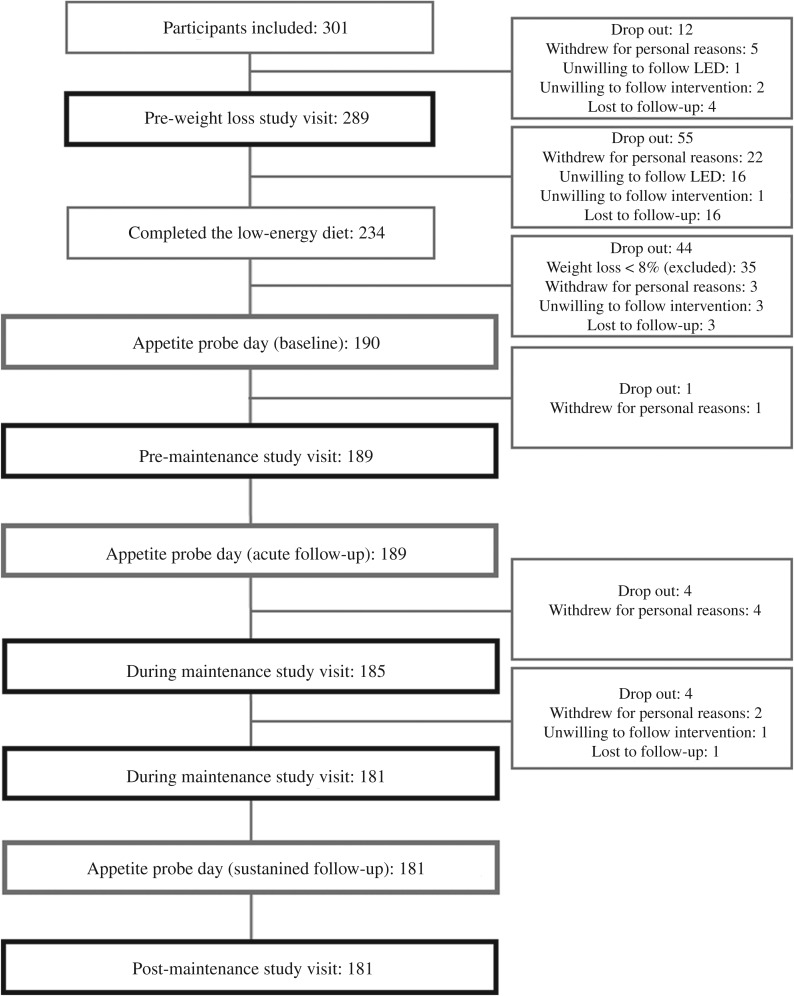
Flow chart of participants completing each visit including explanations for drop out. LED, low-energy diet.